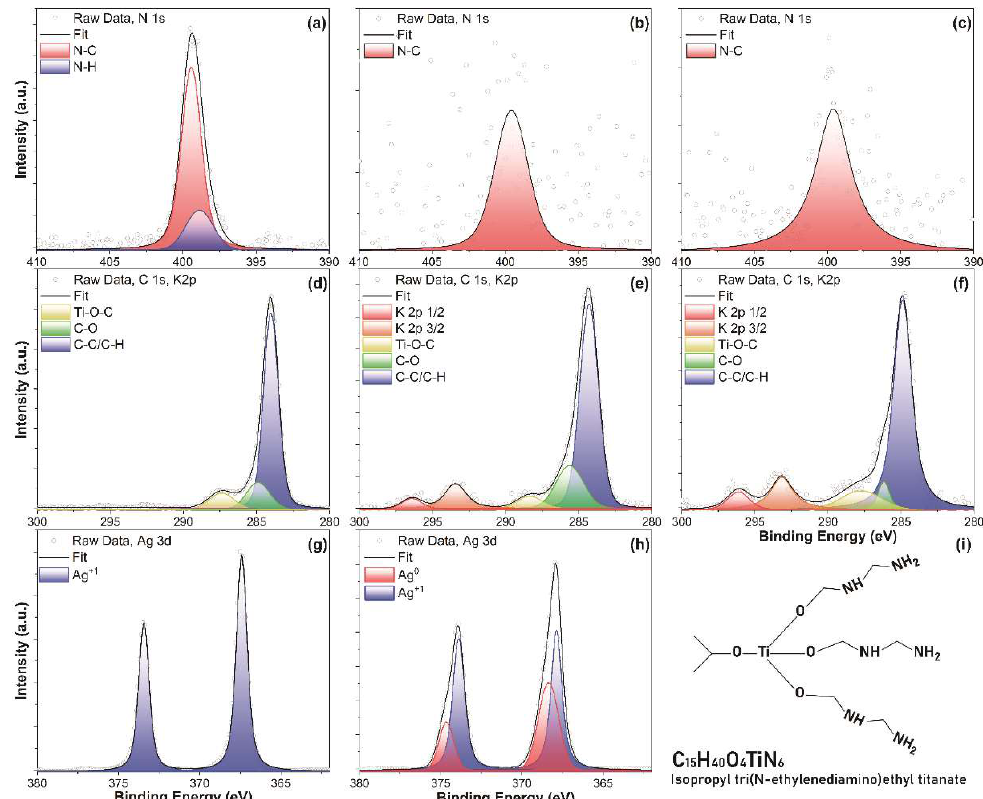
Figure 4. High-resolution X-ray photoelectron spectroscopy (XPS) spectra of N 1s for ITO@Ag(7.5 wt.%) thin film heat-treated at ( a ) 220 °C, ( b ) 750 °C, and ( c ) ITO thin film heat-treated at 750 °C, C 1s for ITO@Ag (7.5 wt.%) thin film heat-treated at ( d ) 220 °C, ( e ) 750 °C, and ( f ) ITO thin film heat-treated at 750 °C, Ag 3d for ITO@Ag (7.5 wt.%) thin film heat-treated at ( g ) 220 °C, ( h ) 750 °C, and